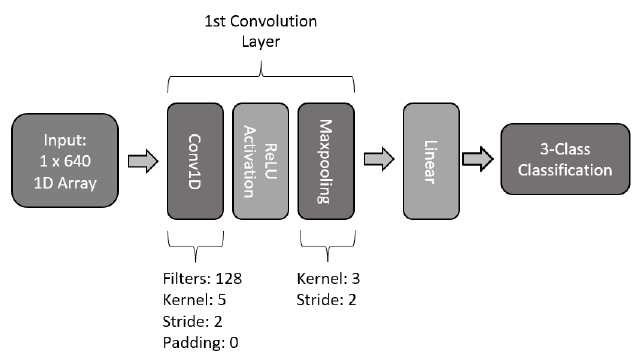
Figure 15. Architecture of single-layer 1D CNN